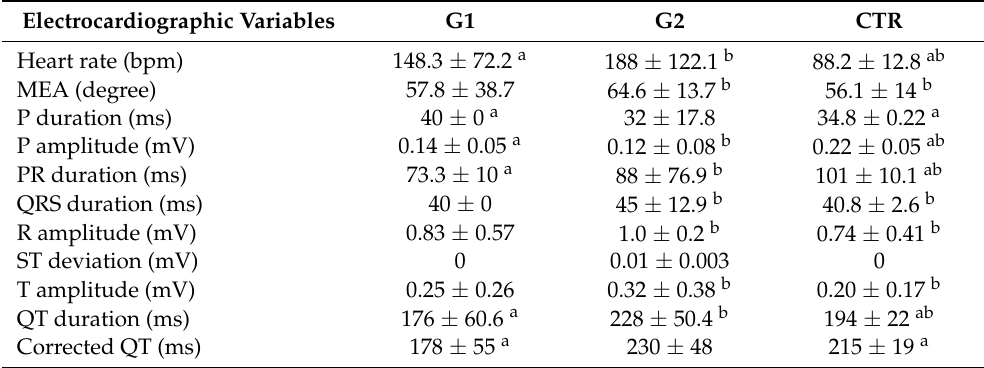
Table 6. Comparison of electrocardiographic parameters between animals with a favorable prognosis (G1), poor (G2) prognosis and control (CTR). Data are expressed as the mean and standard deviation.